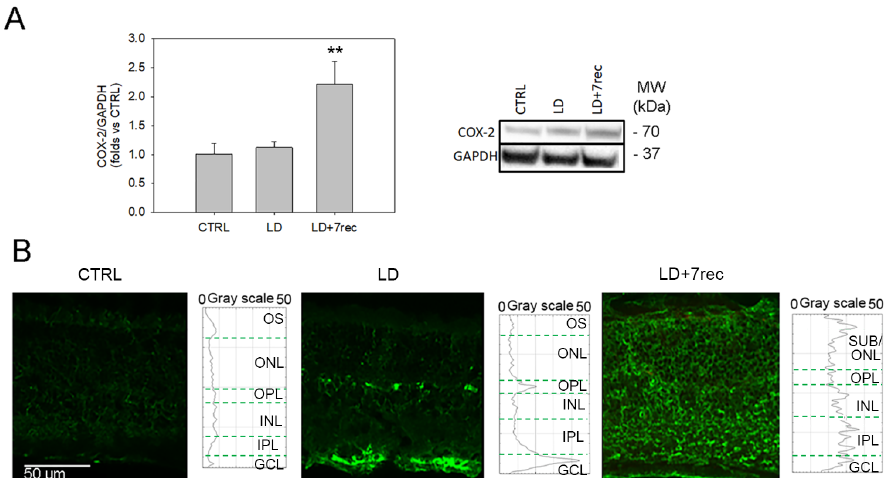
Figure 1. COX-2 analysis. ( A ) Western blot analysis of COX-2 in eye cup samples of all the experimental conditions. Statistical analysis was one-way ANOVA test followed by Tukey test. Data are shown as mean ± SE ( n = 6). ** p < 0.01 versus CTRL. The whole Western blot is available as Supplementary Figure S1. ( B ) Confocal images of retinal cryosections immunolabelled for COX-2 (green) acquired at the central dorsal area of the retina. The graphs show the plot profile fluorescence intensity of COX-2 through the retinal layers. CTRL (Control); LD (Light damage); LD + 7rec (Light damage + 7 days of recovery); OS (outer segments); ONL (Outer nuclear layer); OPL (outer plexiform layer); INL (Inner nuclear layer); IPL (inner plexiform layer); GCL (Ganglion cell layer); ONL/SUB (outer nuclear layer/subretina).